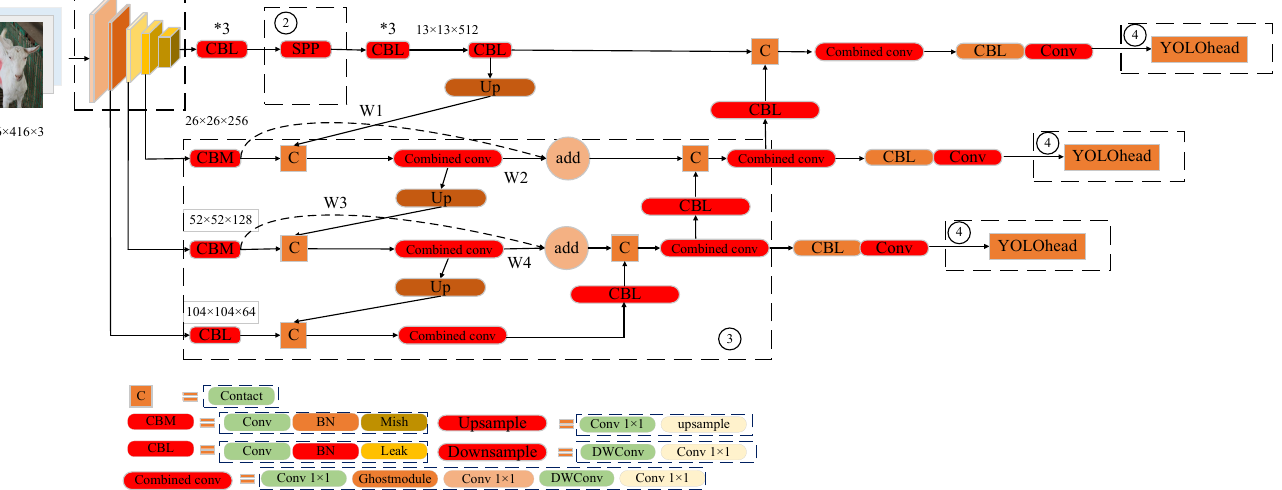
Figure 6. Goat-face-recognition network. Note: 416 × 416 × 3 stands for the input size of image, and 104 × 104 × 64, 52 × 52 × 128, 26 × 26 × 256, and 13 × 13 × 512 stand for four different sizes of feature maps induced from the GhostNet backbone-feature-extraction network, and *3 stands for the number of repetitions of the CBL module